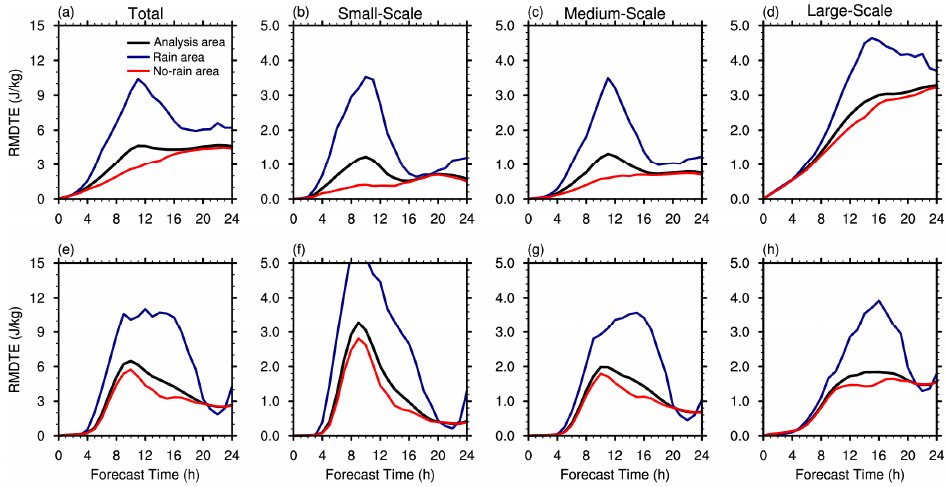
Figure 14. Time series of the domain-average RMDTE in the rain area (hourly precipitation >0.5 mm ∙ h − 1 ) and no-rain area (hourly precipitation <0.5 mm ∙ h − 1 ) at each scale in ( a – d ) the SF case and ( e – h ) the WF case (black line: the whole analysis area; blue line: the rain area; red line: the no-rain area).